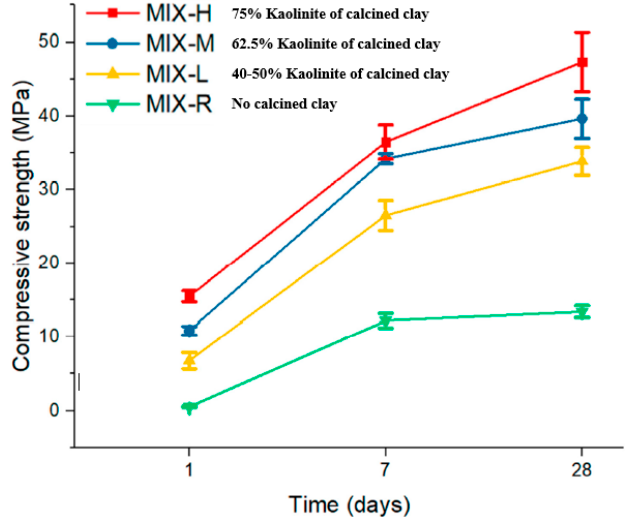
Figure 1. Compressive strength of concrete containing calcined clay with different metakaolin content [65].